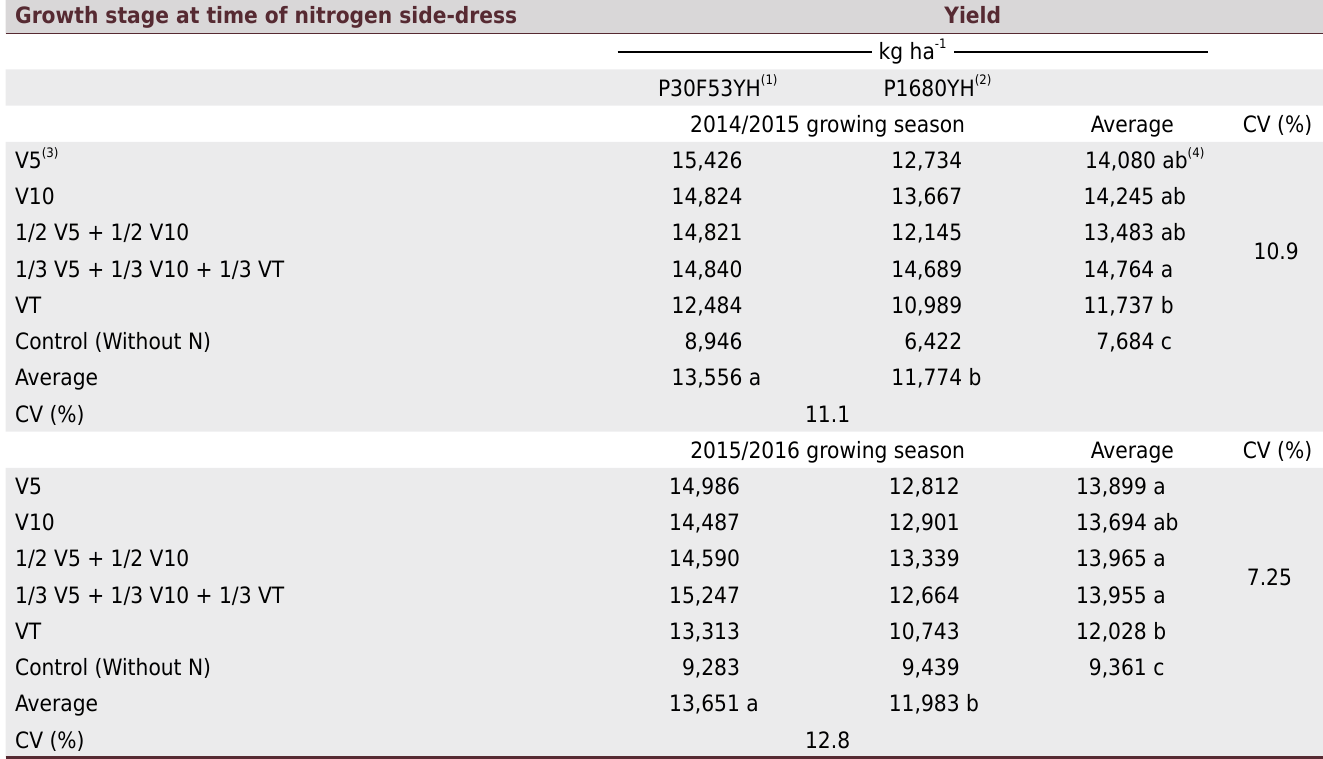
Table 2. Yield of two corn hybrids as affected by the growth stage of plants at the time of nitrogen side-dress fertilization in Lages, Santa Catarina, Brazil Growth stage at time of nitrogen side-dress Yield